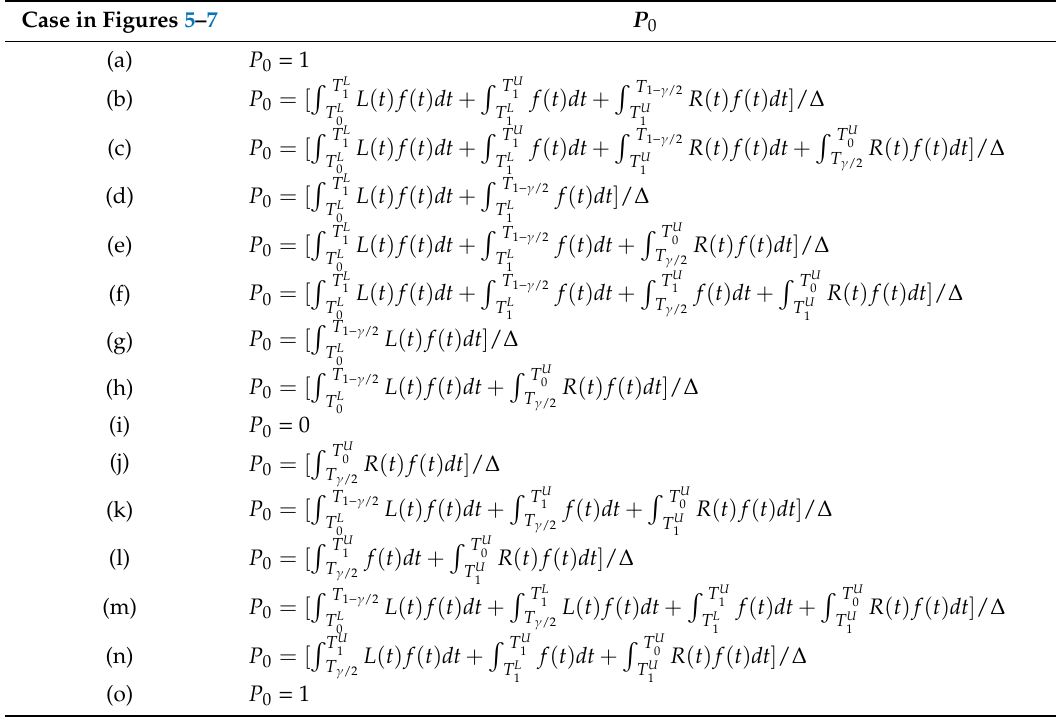
Table 3. The possibility P 0 for the two-sided